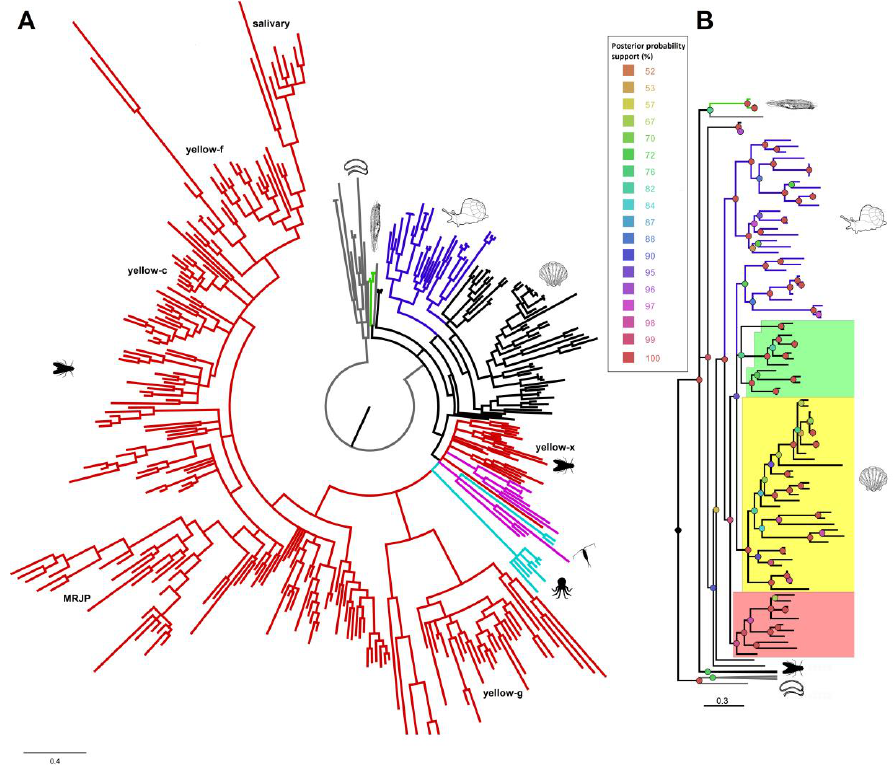
Figure 3. Bayesian phylogenetic tree obtained from the alignment of metazoan DCE/ yellows . A. Insect sequences are shown in red, copepod sequences in violet, cephalopod sequences in light-blue, black lines denote bivalve hits, blue lines refer to gastropod hits and green lines refer to lancelet proteins. Protozoan and bacterial yellow-like proteins used as outgroup (shown in grey). The different insect groups are marked according to their previous nomenclature ( yellow -x, g, c, f, MRJP and salivary proteins). B . The cladogram zooms into the non-insect DCE/ yellow hits, using the same color-codes. Posterior probability support is reported for each node in a color-scale, ranging from 50 to 100% of support. Icons of representative species show taxonomic groups. The phylogenetic tree and the multiple alignment are included in Supplementary Data 1.